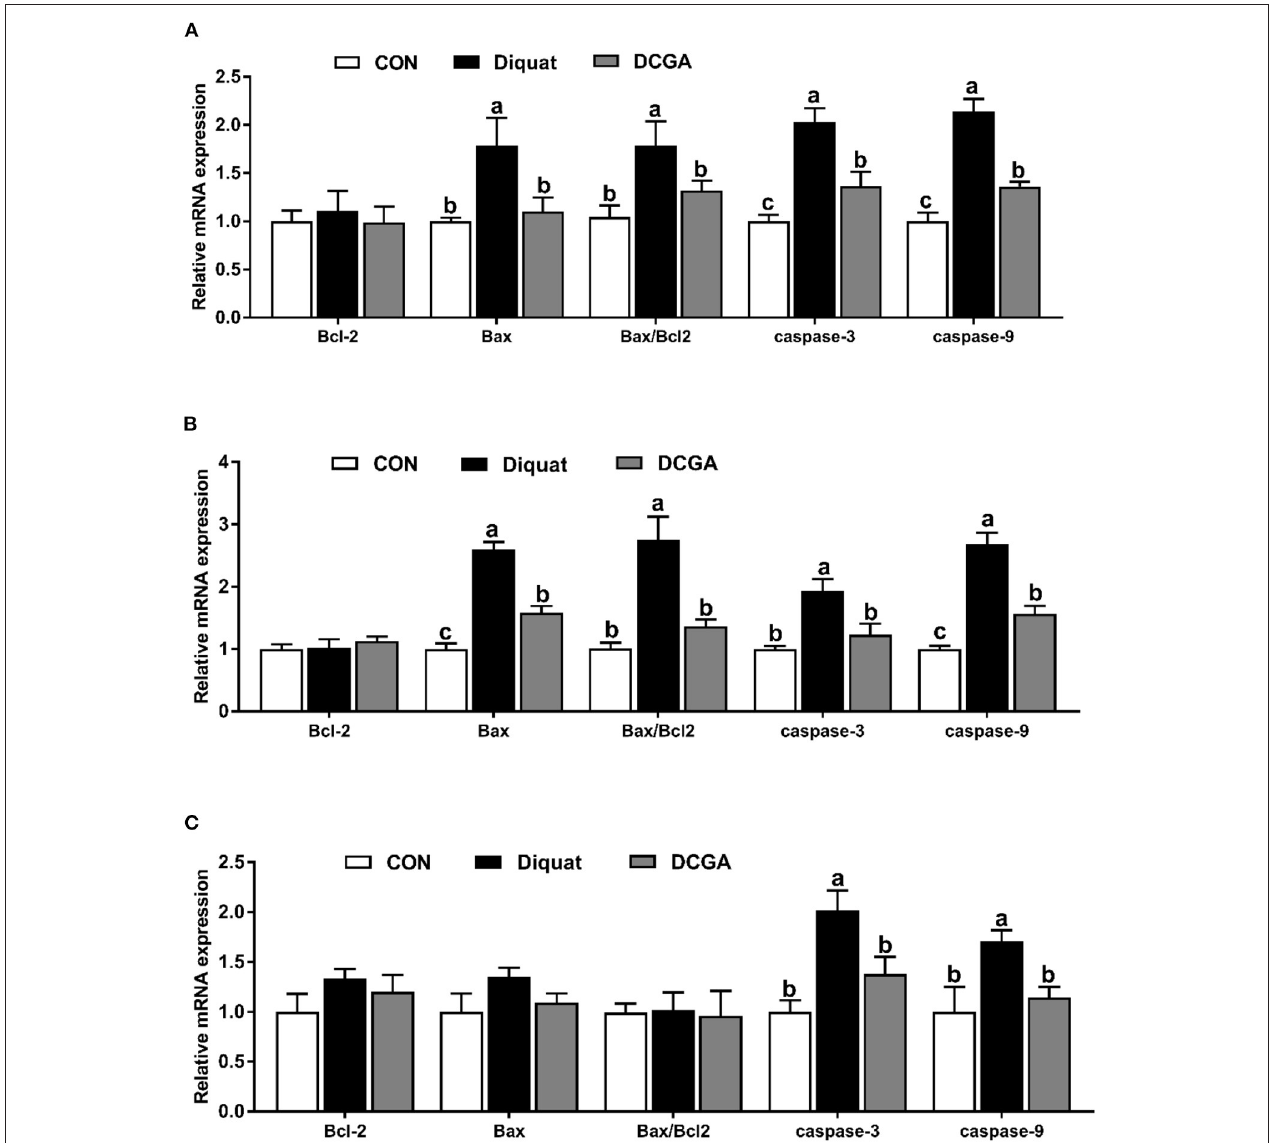
FIGURE 4 | Effects of CGA on expression levels of intestinal barrier-related genes in the Duodenum (A) , Jejunum (B) , and Ileum (C) . ZO-1, zonula occludens 1; CON, piglets fed a basal diet; Diquat, piglets fed the basal diet and challenged by diquat; DCGA, piglets fed the basal diet containing CGA (1,000 mg/kg) and challenged by diquat. a,b Bars with different letters between treatment groups indicate significant differences ( P <